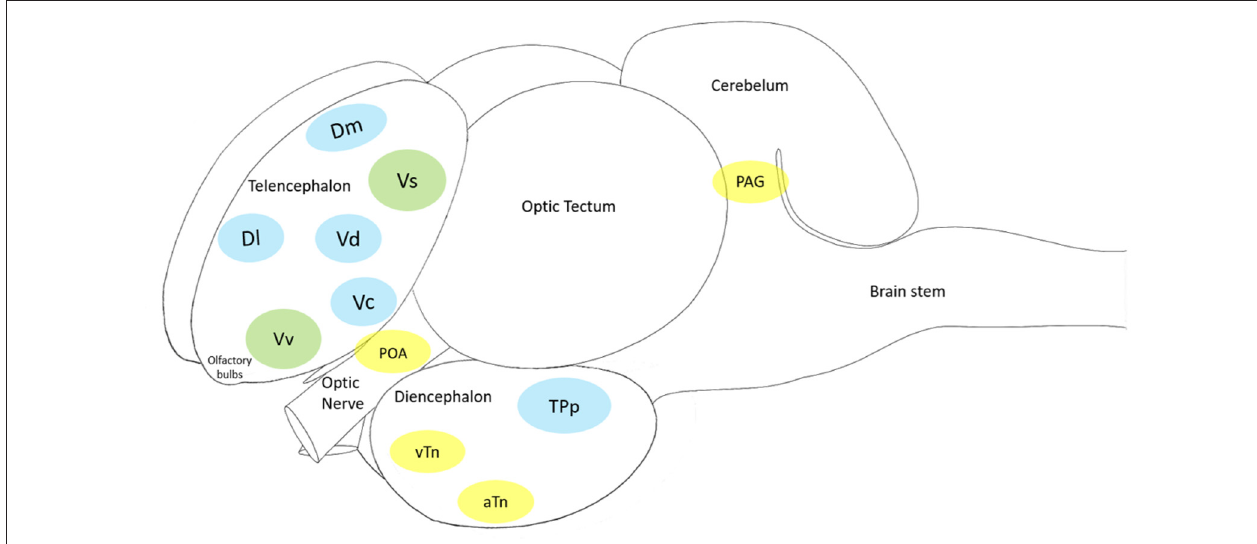
FIGURE 4 | The cleaner fish Labroides dimidiatus brain schematics, showing the main macroa-areas: olfactory bulbs, telencephalon, diencephalon, optic tectum, cerebellum and brain stem. In blue: the Mesolimbic Reward System (MRS); in yellow: the Social Behavior Network (SBN) and in green: the Social Decision-Making Network (SDN—MRS + SBN). Each of the 11 brain nuclei (showed in color) has a putative mammalian counterpart: the medial zone of the dorsal telencephalic area (Dm, putative homolog of the mammalian basolateral amygdala) and the lateral zone of the dorsal telencephalic area (Dl, putative homolog of the mammalian hippocampus), the preoptic area (POA), the ventral nucleus of the ventral telencephalic area (Vv, putative homolog of the mammalian lateral septum) and the supracommissural nucleus of the ventral telencephalic area (Vs, putative homolog of the mammalian medial extended amygdala and the bed nucleus of the stria terminalis), the dorsal part of the ventral telencephalon (Vd, putative homolog of the mammalian nucleus accumbens), the central part of the ventral telecephalon (Vc, putative homolog of the mammalian striatum), the periventricular nucleus of the posterior tuberculum (TPp, putative homolog of the mammalian ventral tegmental area), the ventral tuberal nucleus (vTn, putative homolog of the mammalian anterior hypothalamus), the anterior tuberal nucleus (aTn, putative homolog of the mamalian ventromedial hypothalamus) and the midbrain periaqueductal gray (PAG, putative homolog of the mammalian periaqueductal